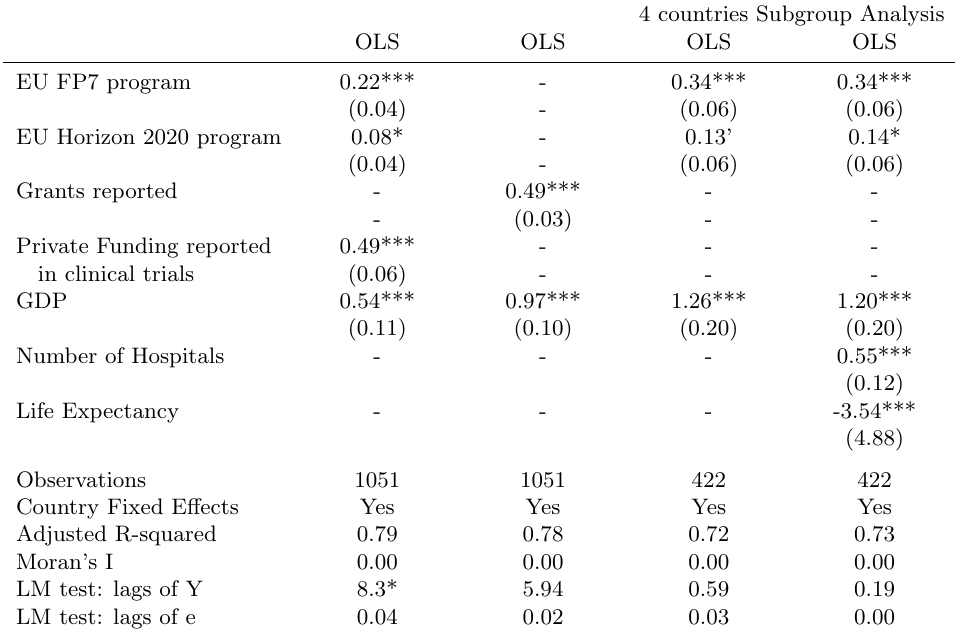
Table 4: Estimates of (Spatial) Knowledge Production Function by scientific publications per capita, additional inputs by number of grants reported, private funding, health system related factors – Inputs and outputs per capita (log-scale incl.